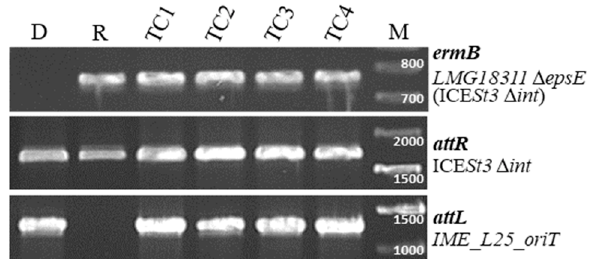
Figure 4. PCR analysis of four transconjugants (TC1 to TC4) obtained using the mating pair LMG18311(ICE St3 ∆ int ::IME_ SsalL25_oriT ) (donor D) / LMG18311 ∆ epsE (ICE St3 ∆ int ) (recipient R). Specific regions were amplified to discriminate the recipient strain, ermB for ∆ epsE , and attL for IME_ SsalL25_oriT . The integrase deletion (done by insertion of a chloramphenicol resistance cassette) was detected with the amplification of the attR site of ICE St3 . The sizes of the PCR fragments were confirmed by parallel migration of a DNA ladder (M for marker on the figure). The primers pairs used for these amplifications and expected sequence lengths are listed in Table S1.